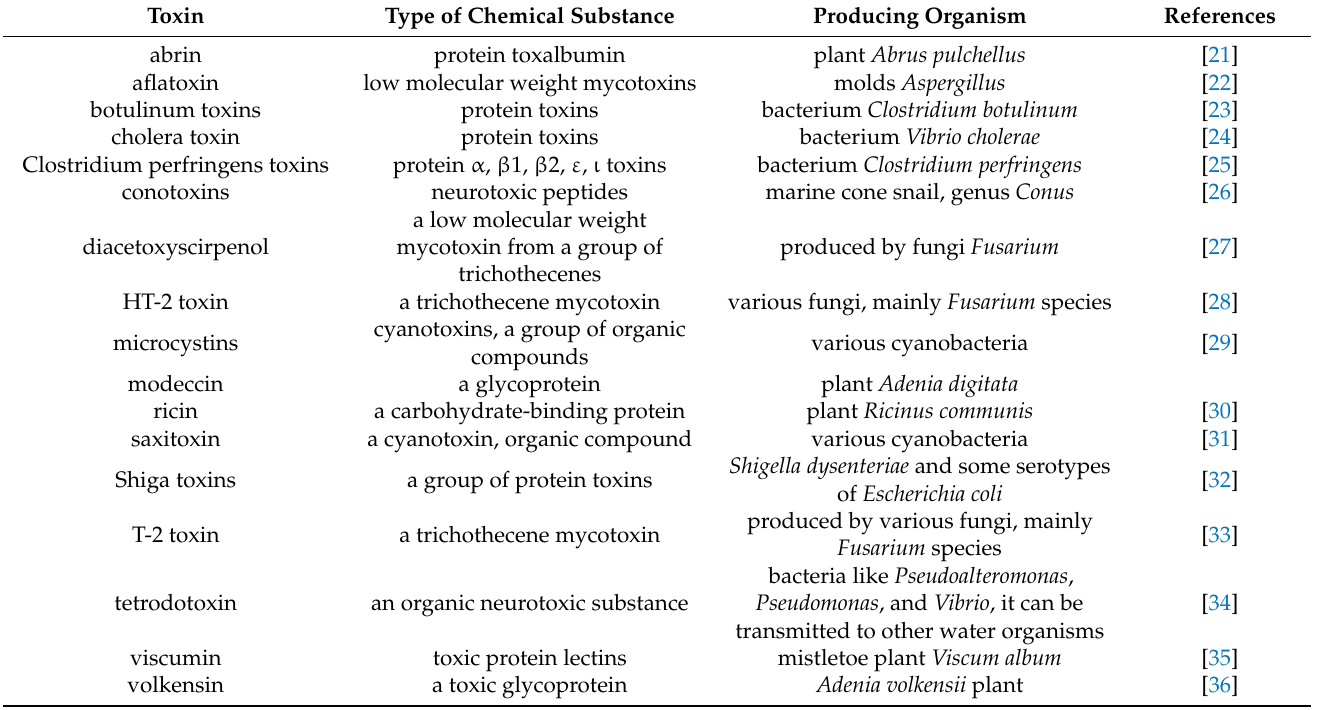
Table 1. Toxins with relevance as biological warfare